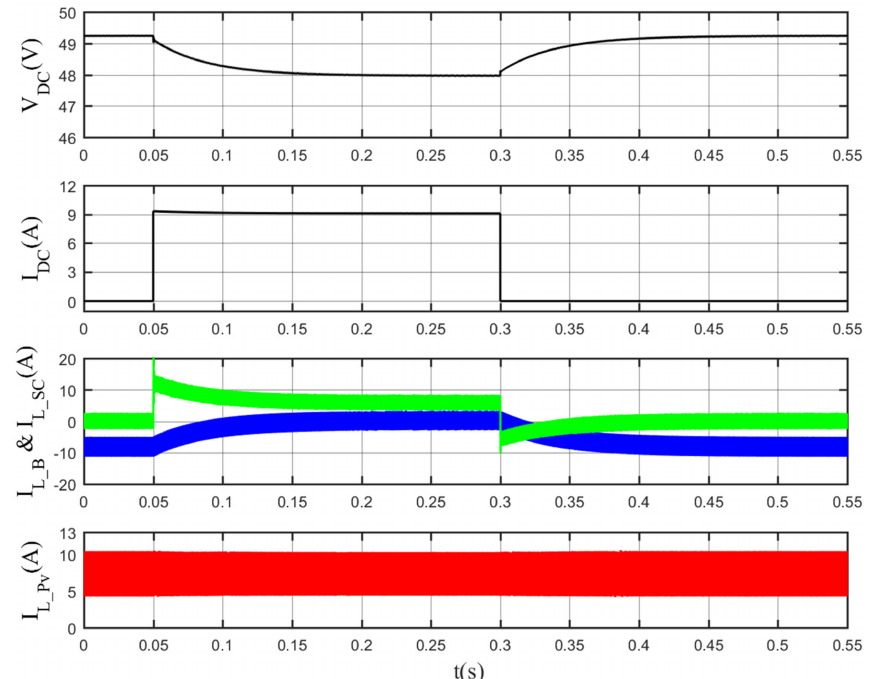
Figure 9. Simulation for dual droop scheme at supercapacitor voltage V SC = 36 V when the load changed from no-load to 5.2 Ω and back to